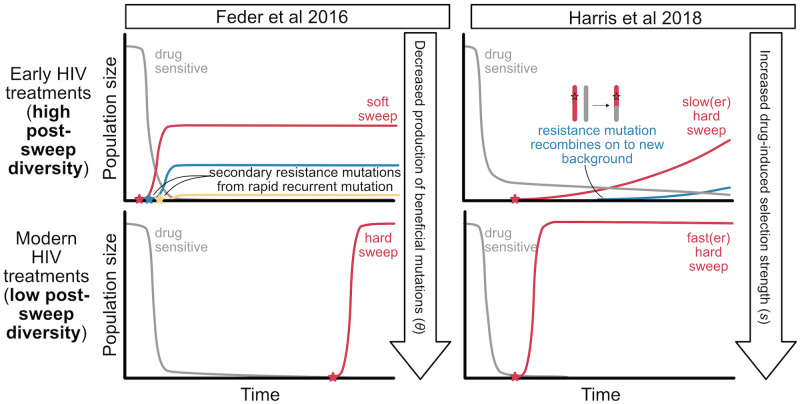
Cartoon of explanations for post-sweep diversity loss patterns observed in Feder et al. [11].We seek to explain why more diversity is retained following the fixation of drug resistance to early, ineffective therapies than modern, effective ones. The soft sweeps of recurrent mutations hypothesis [11] suggest that the primary difference is that θ is high for ineffective drugs, leading to short waiting times between resistance mutations and subsequent soft sweeps (top left), whereas θ is lower for effective drugs, leading to long waiting times between resistance mutations subsequent and hard sweeps (bottom left). The recombination-rescued diversity hypothesis [12] suggests that the primary difference is the opportunity for recombination to rescue diversity following a beneficial mutation: Sweeps in response to ineffective drugs are slow and occur after wider population bottlenecks, which gives recombination time to rescue diversity (top right). Sweeps in response to effective drugs are fast and occur after narrow population bottlenecks, so recombination has less opportunity to rescue genetic diversity (bottom right). Stars represent drug resistance mutations entering the population de novo and drug pressure starts at the x-intercept.